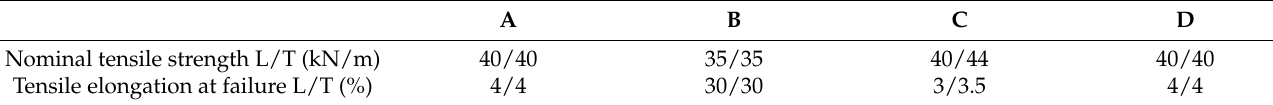
Figure 2. Scheme of the cross-section ( a ) and upper surfaces ( b ) of the geocomposites. Table 1. Mechanical properties of the